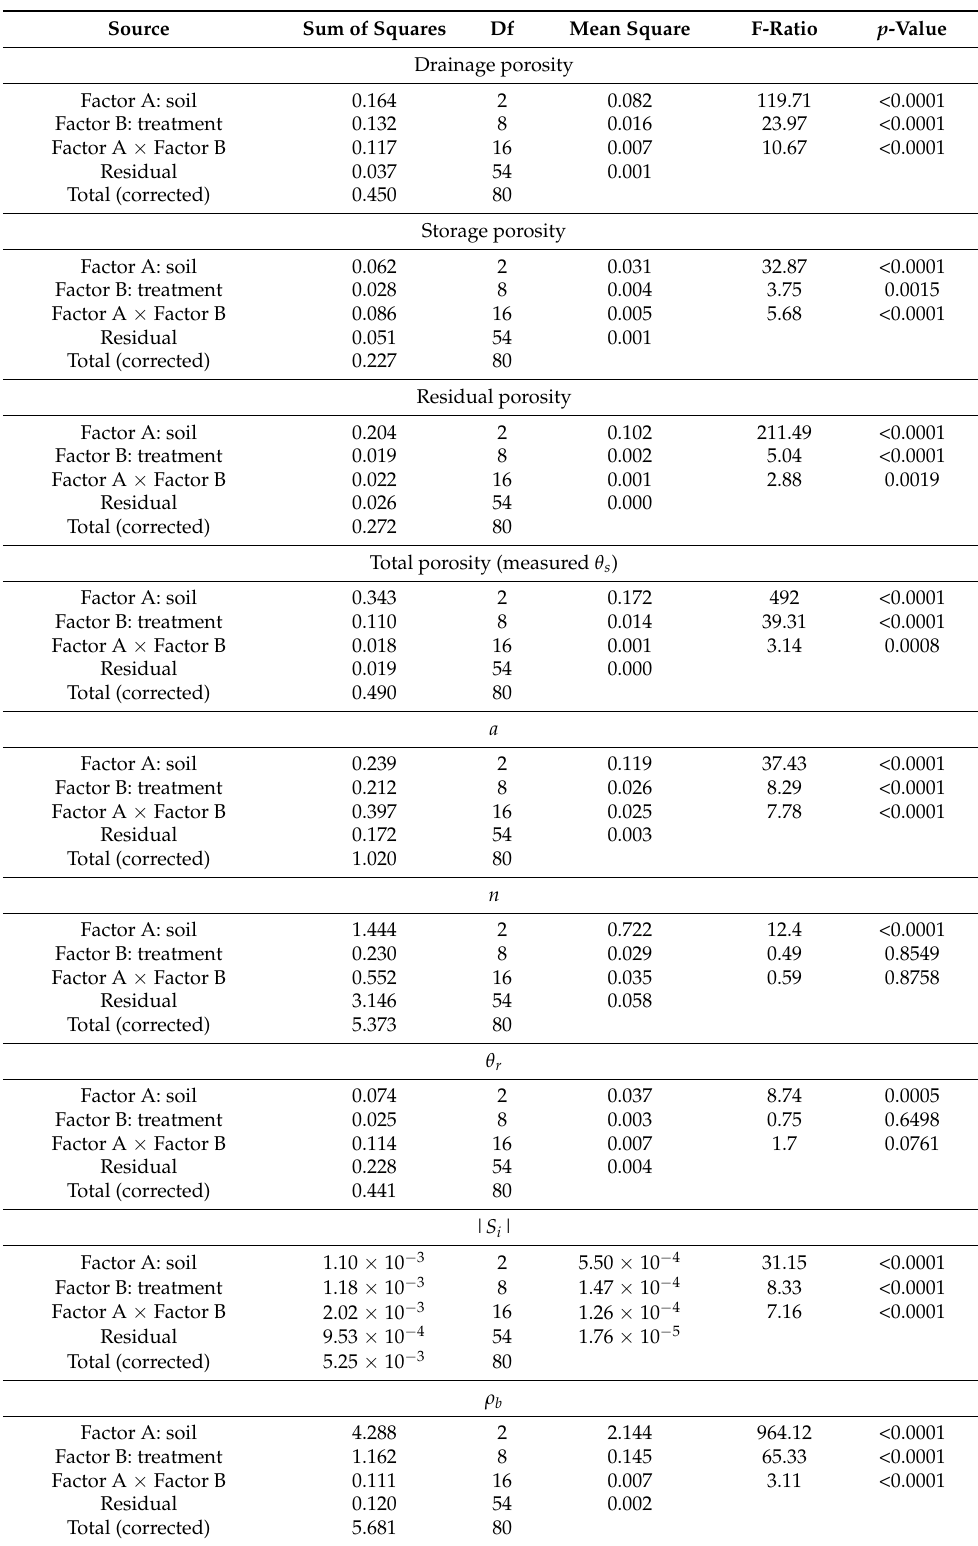
Table 3. Two-way ANOVA of soil types and treatment effects on different porosity attributes, van Genuchten parameters, and ρ b